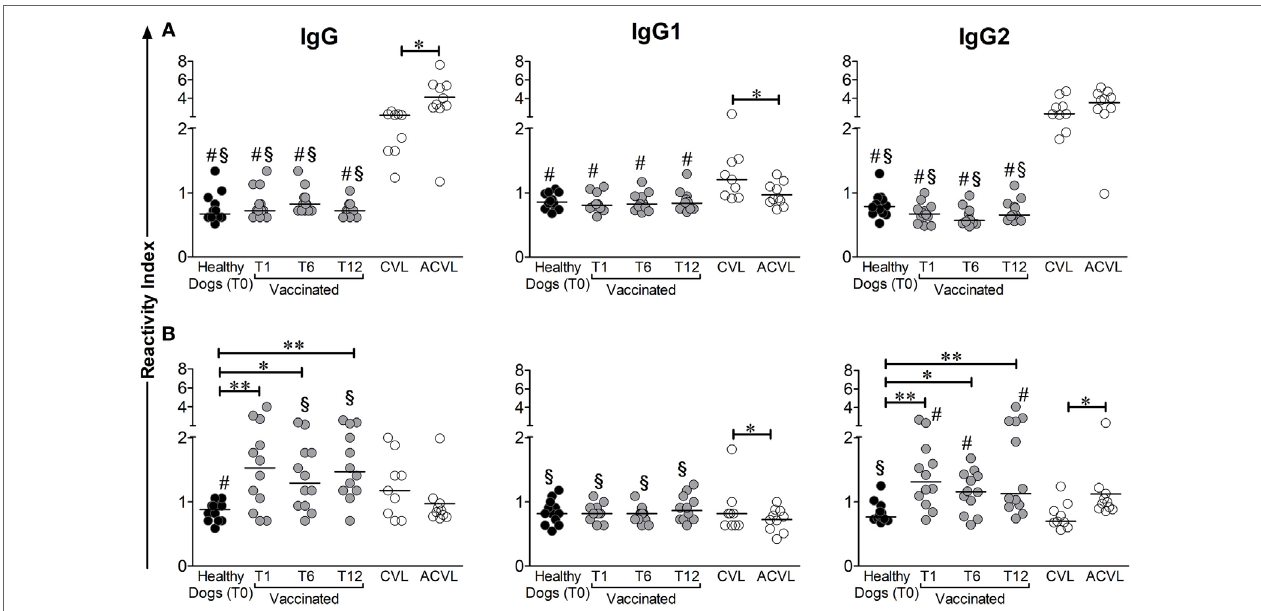
FigUre 1 | Medians of reactivity indexes of total IgG, IgG1, and IgG2 subclass against LiAg (a) and A2 protein (B) detected in the serum of infected symptomatic canine visceral leishmaniasis dogs (CVL), infected asymptomatic dogs (ACVL), healthy controls (T0), and vaccinated dogs 1 (T1), 6 (T6), and 12 months (T12) after the end of immunization protocol. Wilcoxon’s paired non-parametric test was used to compare samples from healthy and immunized groups. The Mann–Whitney test was used to compare samples between vaccinated and CVL or healthy and CVL groups. # different from CVL, § different from ACVL. * p < 0.05, ** p <